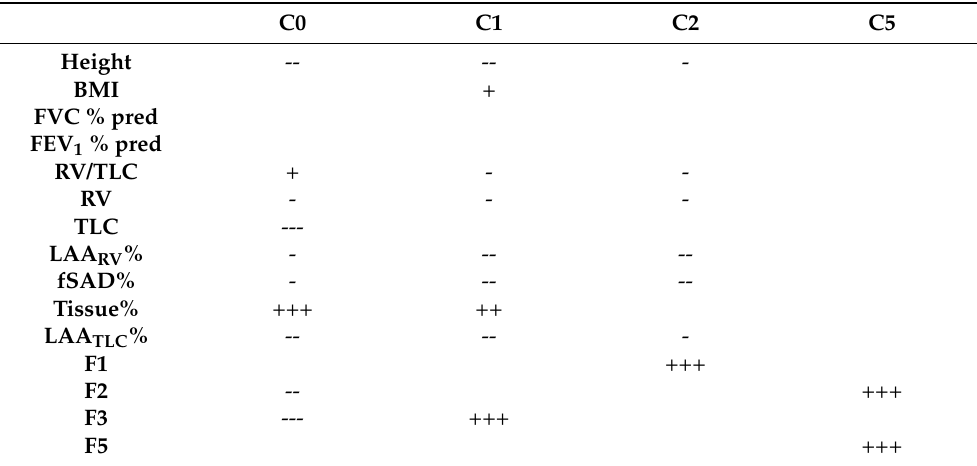
Table 4. Pair-wise contrasts for C0, C1, and C2, with C5 as a reference group. C0 C1 C2 C5 Height -- --